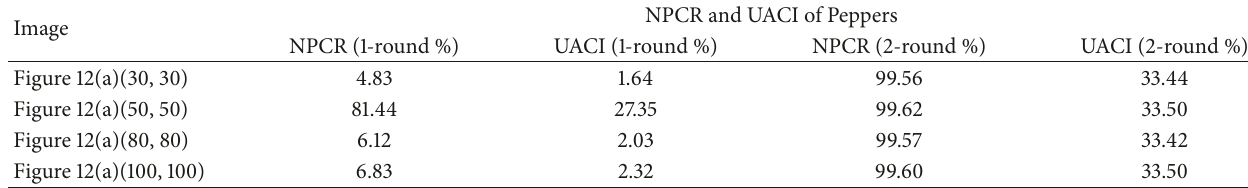
Table 10: NPCR and UACI between cipher-images with slightly different plain-images. Image